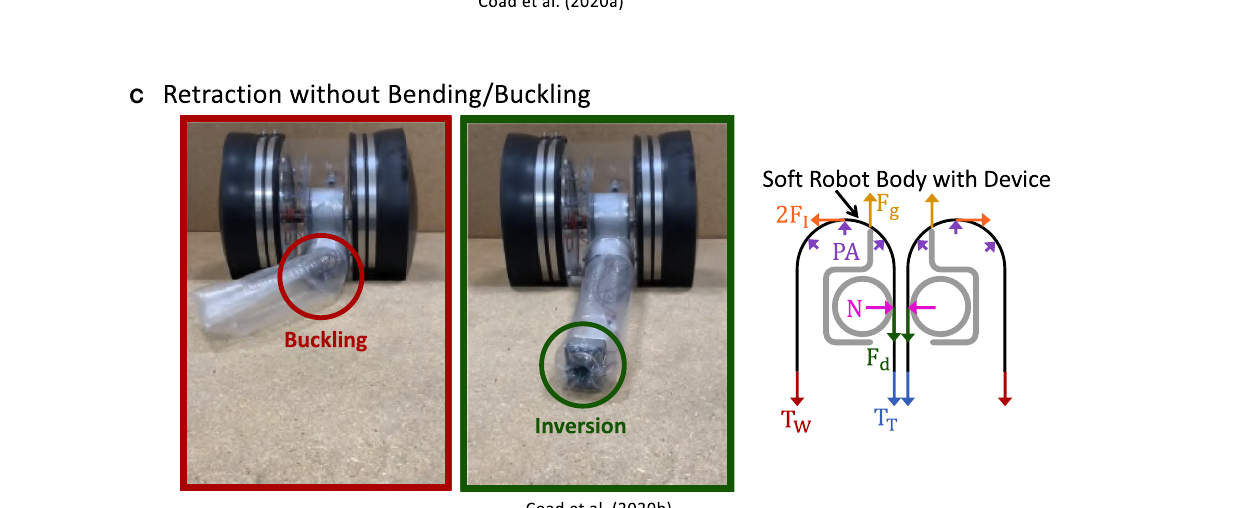
FIGURE 2 | Designs for actuating length change of everting vine robots. (A) Storing robot body material on a spool in the base allows growth to arbitrary lengths. (B) Reversing the spool direction with a motor allows retraction after growth. (C) Adding a retraction device at the robot tip allows retraction without undesired bending or buckling of the robot body. Modified from Hawkes et al. (2017). Reprinted with permission from AAAS. Modified from Luong et al. (2019) © IEEE 2019, Coad et al. (2020a) © IEEE 2020, and Coad et al. (2020b) © IEEE 2020.